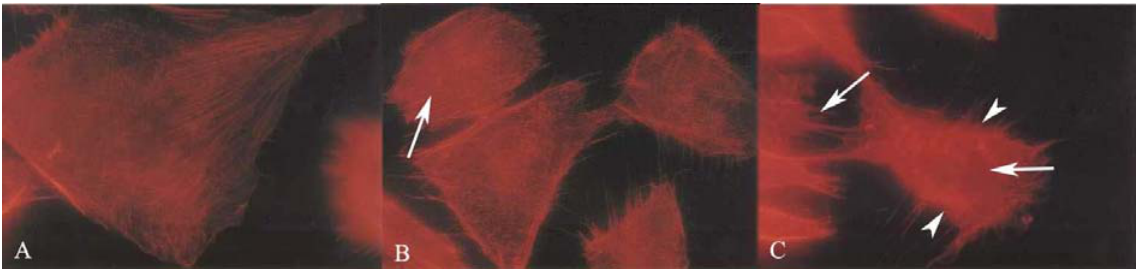
Figure 1: Visualization of actin filaments of CHO-K1 cells after C. d. terrificus crude venom treatment. (A) Control cells. Note the normal appearance of actin filaments and spreading of cells. (B) Cells treated with 10 μ g/ml of venom for 24 hours. Some actin filaments can be seen (arrow). (C) Cells treated with 100 μ g/ml of venom for 24 hours. Depolymerization of actin filaments (arrows) and compromised cell adhesion resulting in membrane retraction (arrowheads) can be seen. X 2,500.